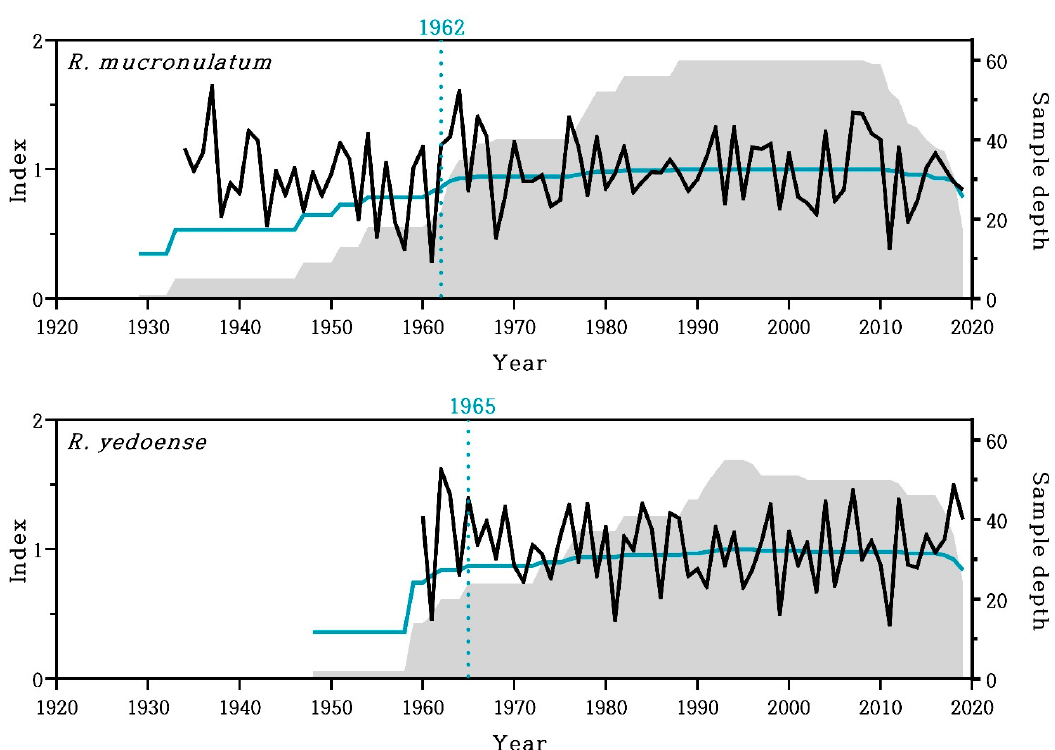
Figure 6. Residual chronologies (black line) of R. mucronulatum and R. yedoense with the years over the threshold of Expressed Population Signal (EPS 0.85) (blue dashed vertical line) to decide the period to compare with BioClim variables (grey backgrounds: sample depth and blue lines: EPS). Table 3. Statistics information on the chronologies of R. yedoense and R. mucronulatum (Rwt: corre- lation coefficients within trees, Rbt: correlation coefficients between trees, EPS: expressed popula- tion signal, AC1: first-order autocorrelation).